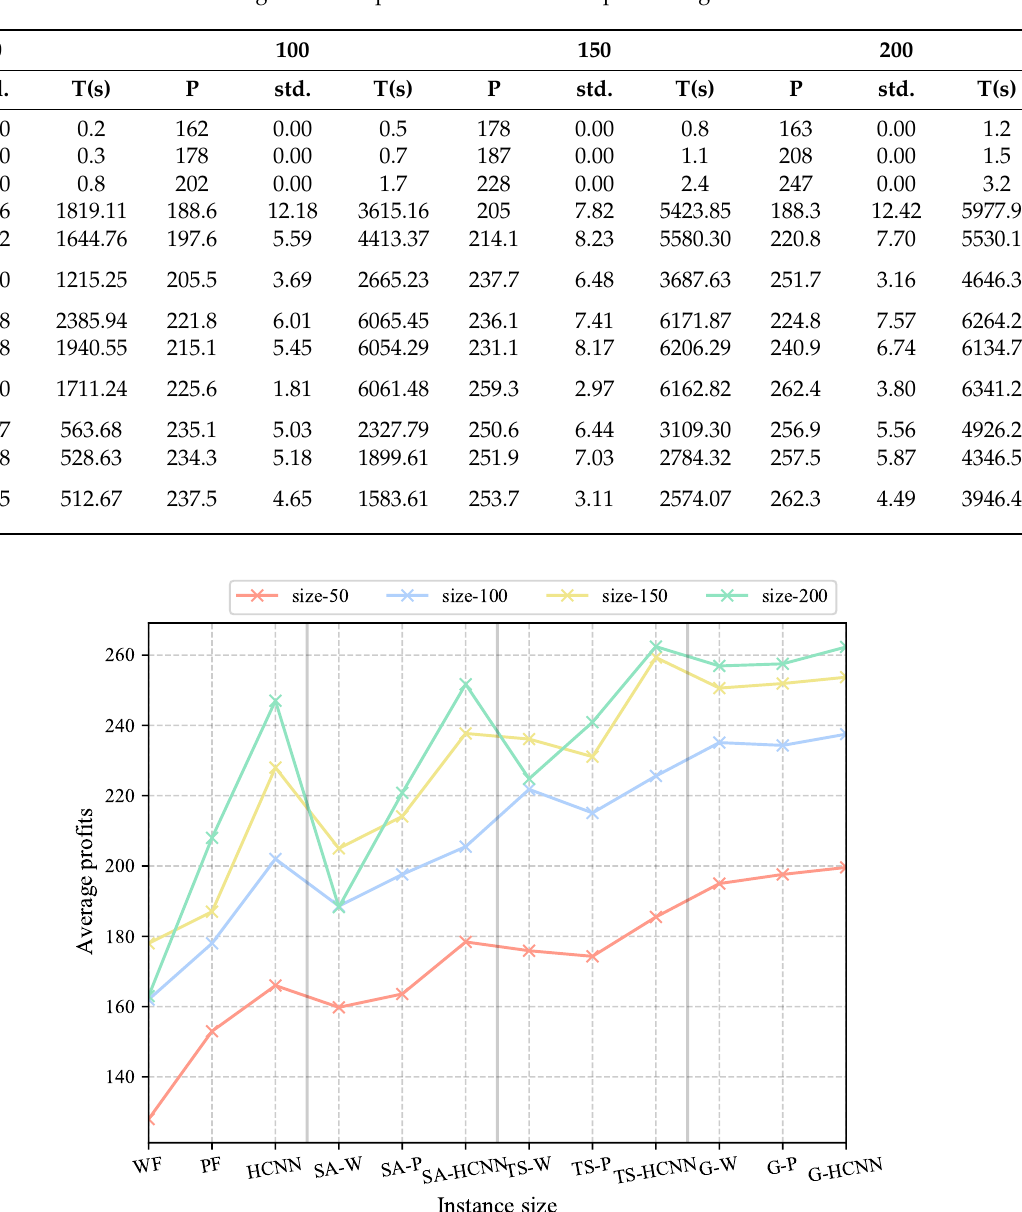
Table 10. The average total task profit results of the comparison algorithms under different task scales.